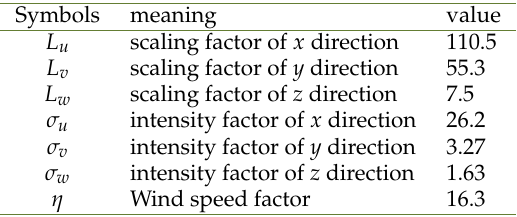
Table 2. Turbulent flow